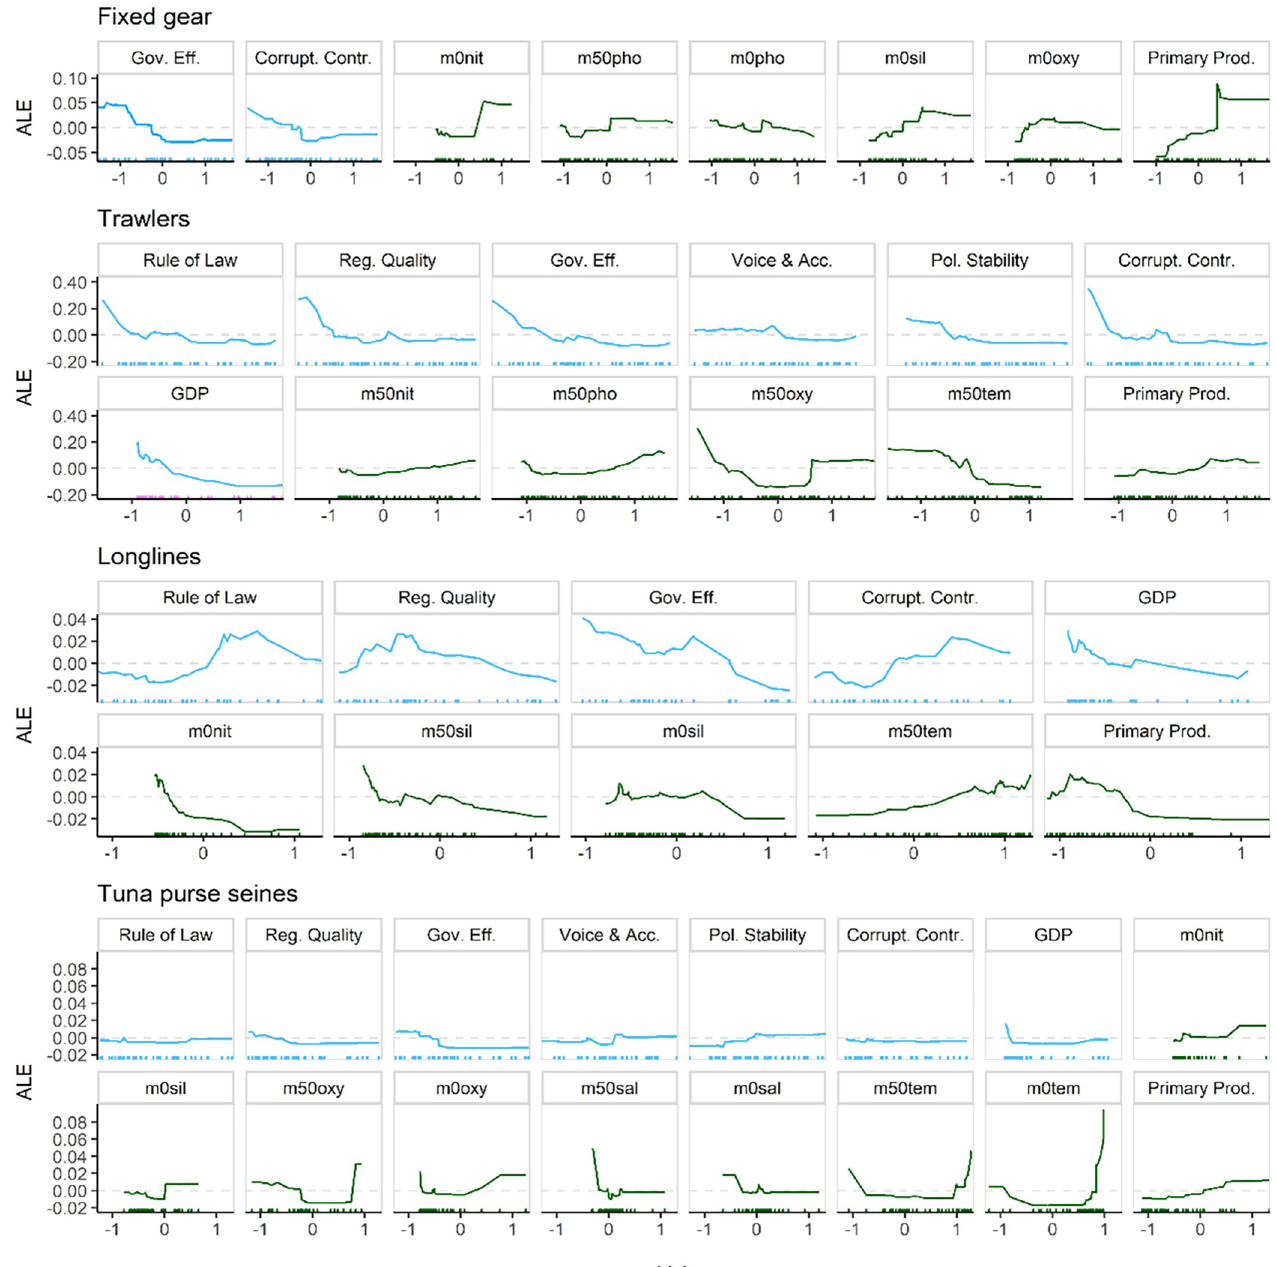
Fig 3. The influence of (normalized) environmental (green) and socio-political variables (blue) on DWF effort, as predicted by our random forest models and expressed as accumulated local effects (ALE), for the four fleets. Displayed are only informative variables (more important than a random variable, c.f. Fig 2) and for variable values within the 5 to 95 percentile intervals. Grey dashed lines indicate the 0 ALE level and bars along the x-axis indicate distribution of data points for this variable. Not all variables are more important than random for all four gears, therefore each panel may show different numbers of